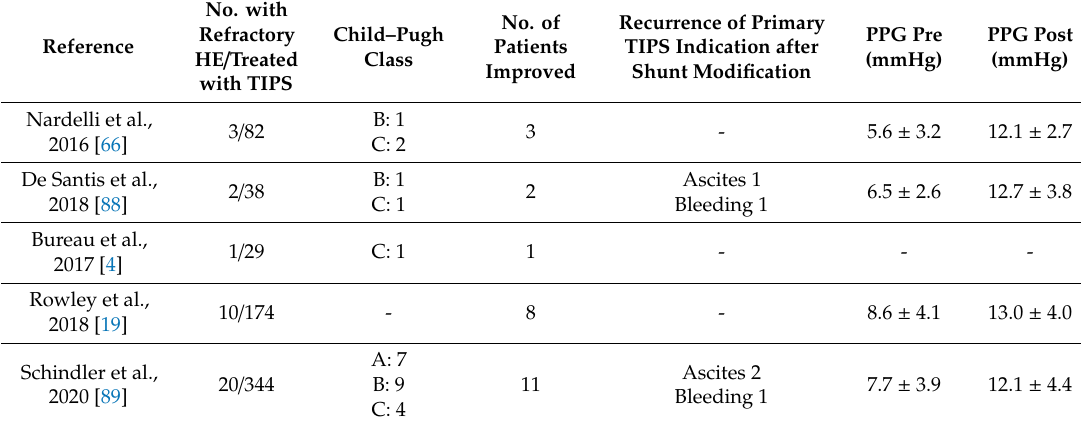
Table 4. Recent relevant publications analyzing the e ff ect of shunt modification in patients with refractory post-TIPS HE (adapted from Nardelli et al.